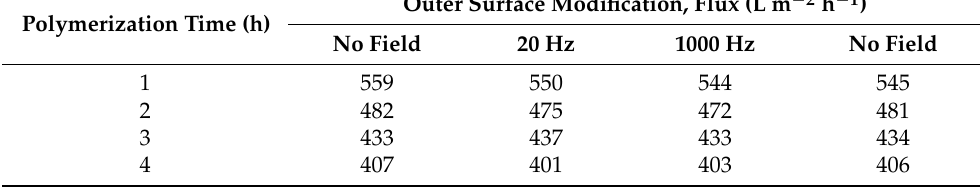
Table 4. Variation of bovine serum albumin (BSA) flux for outer membrane surface modification. Results are shown in the absence and presence of a 20 and 1000 Hz oscillating magnetic field. Average results are provided with a range of ± 8 L m − 2 h − 1 . The feed pressure was 10.3 kPa. Polymerization Time (h)